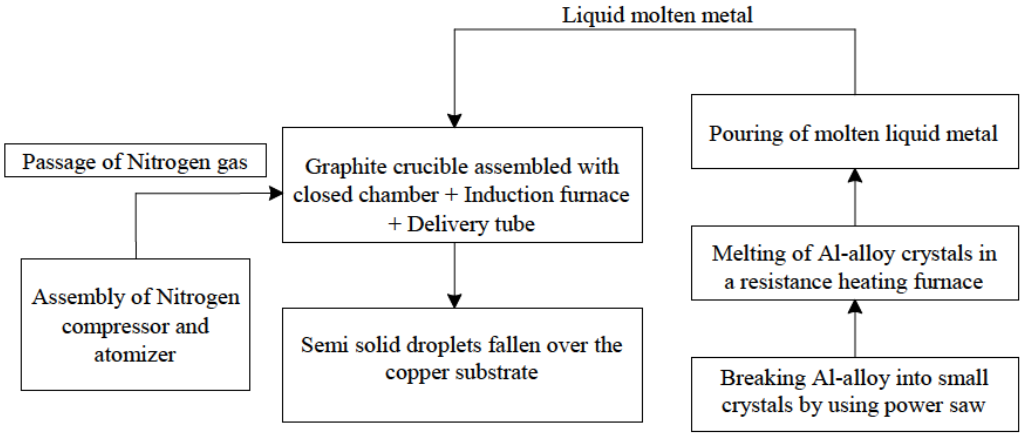
Figure 3: Flow diagram of spray forming processing. Table 2: Optimal processing